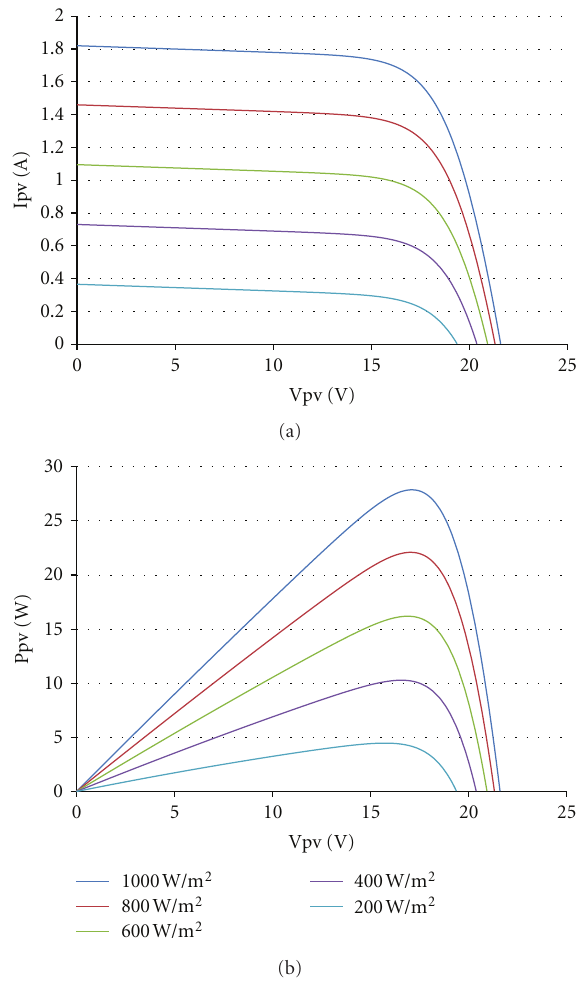
Figure 2: For a SANYO HIP 2717 module, (a) I - V , (b) P - V charac- teristic curves.